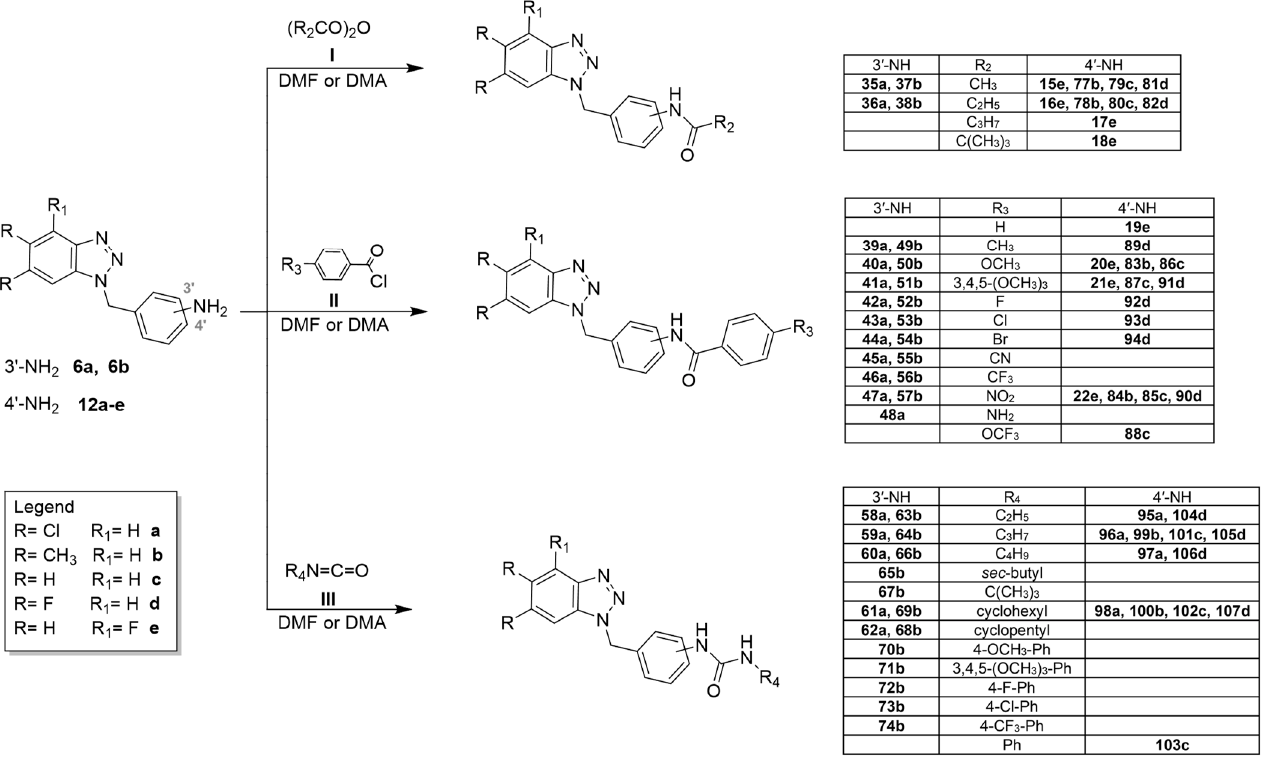
Table 1. Cytotoxicity and antiviral activity of the sole active derivatives against one or more among the following viruses: BVDV, YFV, Reo-1, CVB5, Sb-1, VV, HSV-1, VSV, and RSV. Data represent mean values of three independent